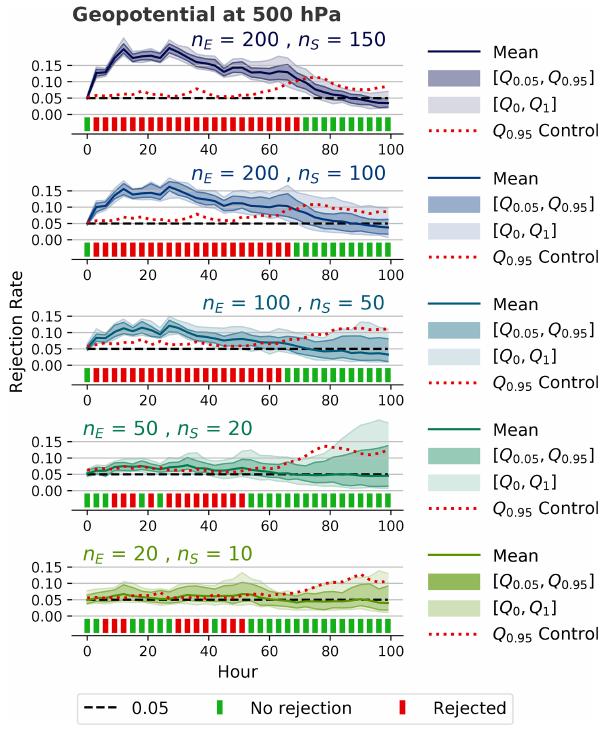
tial, as in Fig. 3, for the diffusion ensemble ( D = 0 . 005) with dif- ferent numbers of ensemble members n E , subsample members n S , and m = 100 subsamples. Larger values for n E and n S increase the sensitivity of the